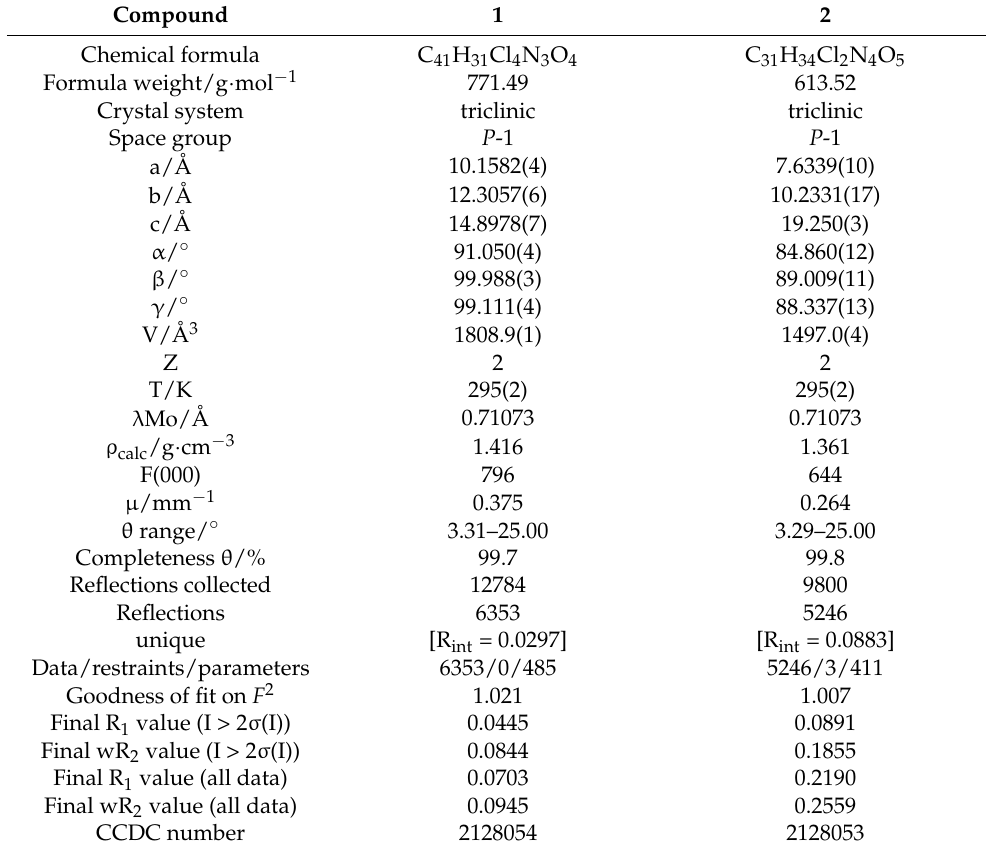
Table 1. Crystal data and structure refinement for compounds 1 and 2